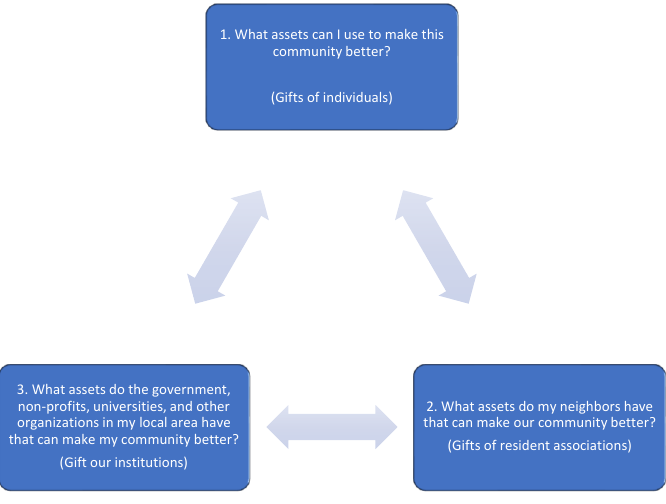
Figure 2. Three basic questions to mobilize community assets. Source: Authors.